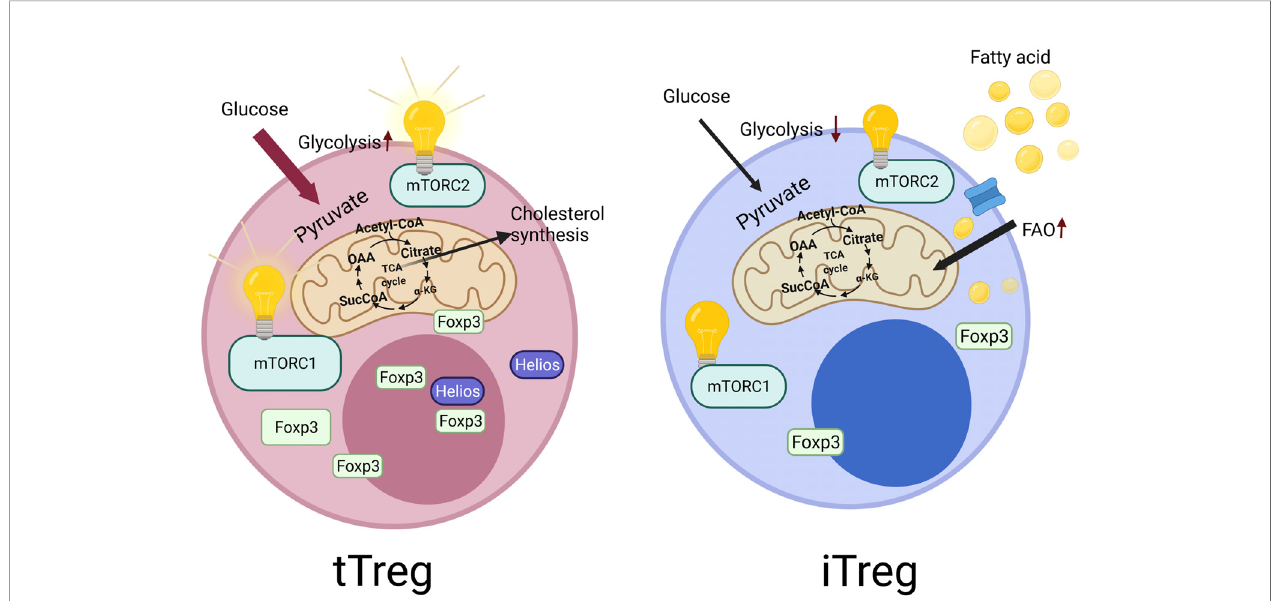
FIGURE 1 | Tregs derived from the thymus called as tTregs, which constitutes the majority of Tregs in humans. They speci fi cally express Helios, which is reported to be essential for the stability of Tregs. In contrast to tTregs, Tregs can also be generated in vitro from the naive CD4 + T cells, which are called as induced Tregs (iTregs), which do not express Helios. These two cell types also differ in terms of their metabolic regulations. iTregs mainly use fatty acid oxidation and have low levels of glycolysis. However, tTregs display higher glycolysis activity. In addition, the central metabolic regulatory pathway, mechanistic target of rapamycin (mTOR) signaling show differences in these cells. tTregs are dependent on the mechanistic target of rapamycin complex 1 and 2 (mTORC1 and mTORC2) activity for their functionality, unlike